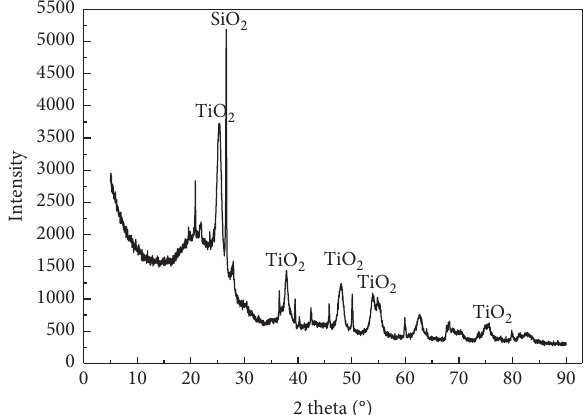
Figure 1: The XRD pattern of the